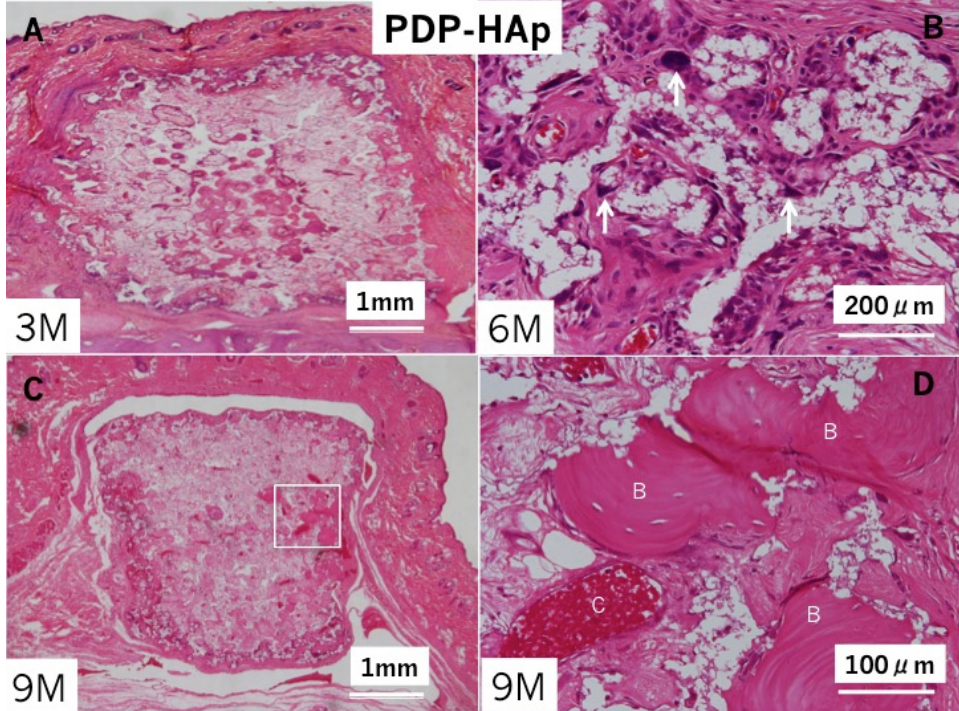
Figure 4. Histological photographs of HE sections in PDP-HAp alone. ( A ) Tissue formation in pores at three months. ( B ) None of bone and cartilage at six months. Arrow: giant cells. ( C ) Rectangle indicating bone induction at nine months. ( D ) Higher magnification of rectangle in ( C ). Induced bone in micro-pores at nine months.